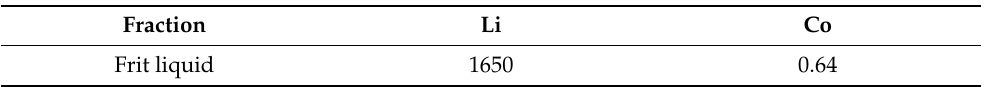
Figure 8. Experimental performance of LCO-C in Design 1: ( a ) comparison of power and temperature over time; ( b ) deposits in the exhaust pipe of the gas scrubber. Table 2. Results from the gas scrubber respectively from its frit liquid after suction of the exhaust gas in Design 1 LCO-C in mg/L.